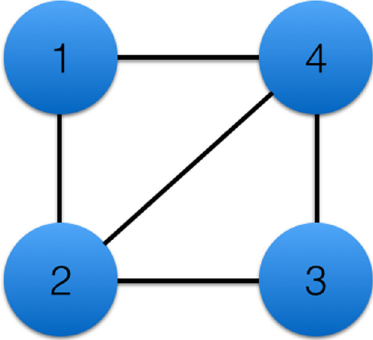
FIG. 1. A four-state system described by a graph. Each node represents a state of the system. The edges represent nonvanish- ing transition rates between states. In this example, direct transitions between states 1 and 3 are not